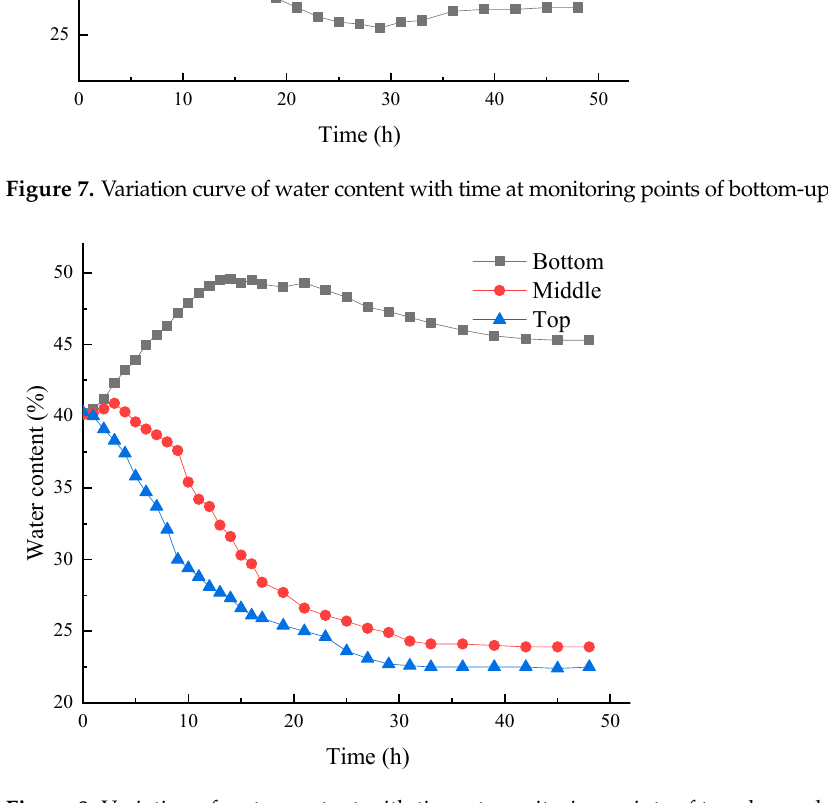
Figure 8. Variation of water content with time at monitoring points of top-down electro-osmosis.